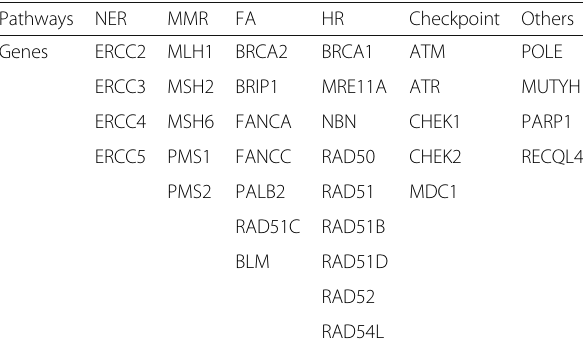
Table 1 DNA damage repair genes included in